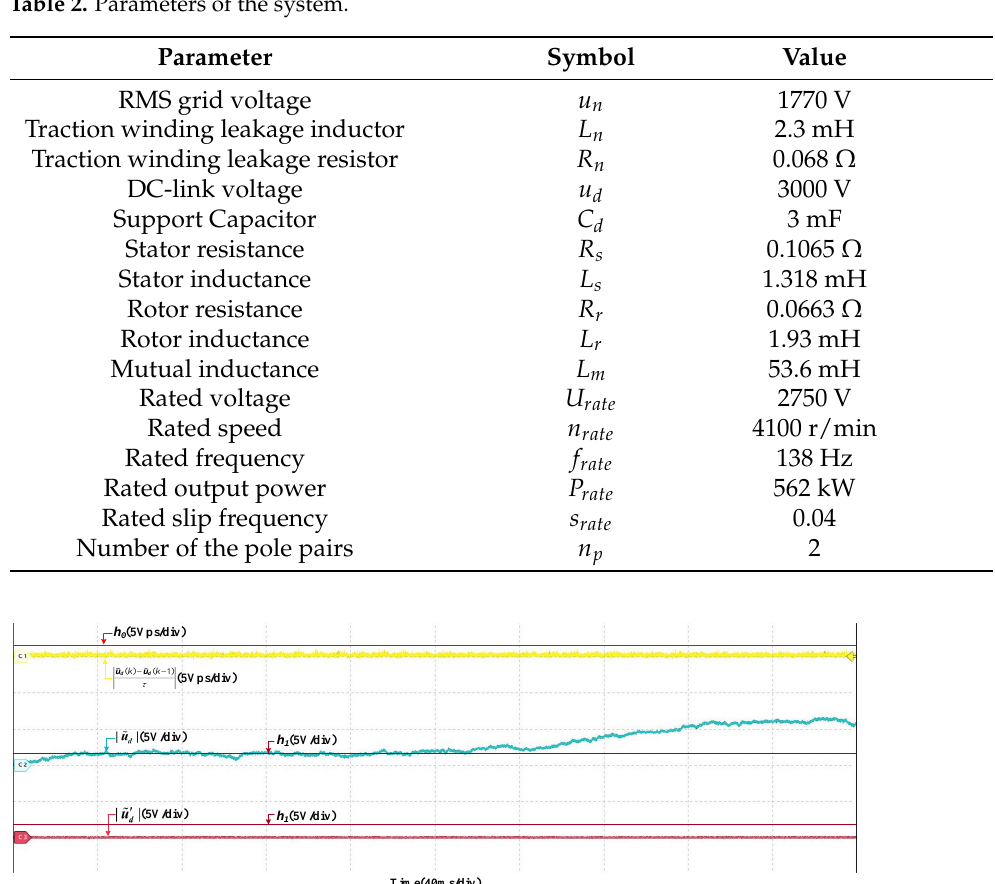
Figure 5. Orignal residual and reconstructed residuals of DC-link voltage in normal condition.